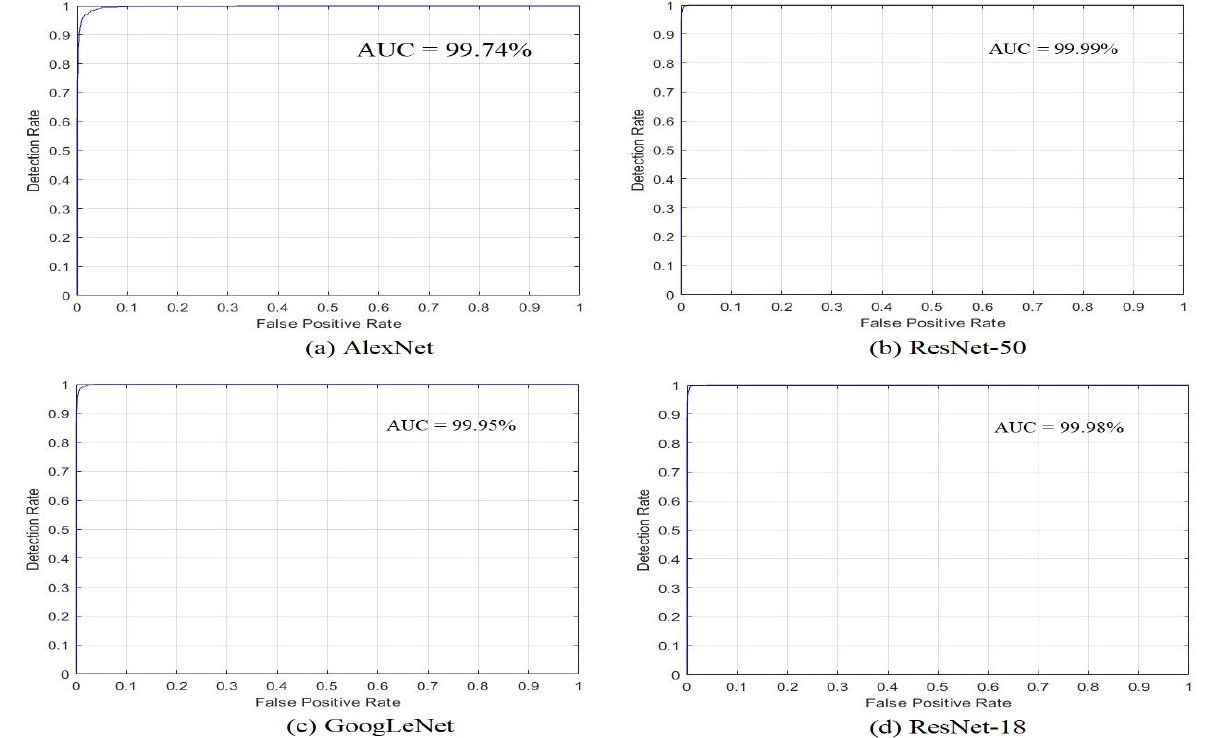
Figure 17. Display showing the ROC for the evaluation of the white blood cell dataset using ( a )